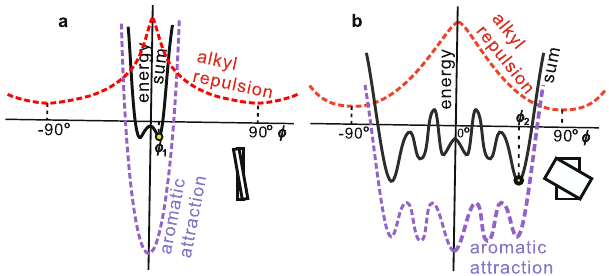
Fig. 7 Schematic depiction of the interaction energy between successive molecules at adjacent z -elevations (strata) within an isolated column as a function of angle of rotation ϕ about the column axis. a For molecular rods one benzene ring wide (present case), b for disc-like or elongated aromatic platelet-like mesogens containing more than one ring in both x and y directions. The solid black line S ( ϕ ) is the sum of energies of attraction between the π -conjugated molecular cores A ( ϕ ) and the repulsion between alkyl end chains R ( ϕ ). For some actual examples of A ( ϕ ) see ref. 37 . Yellow circles indicate global energy minima causing a small twist angle ϕ 1 in rod-like and a larger twist angle ϕ 2 in disc/platelet-like